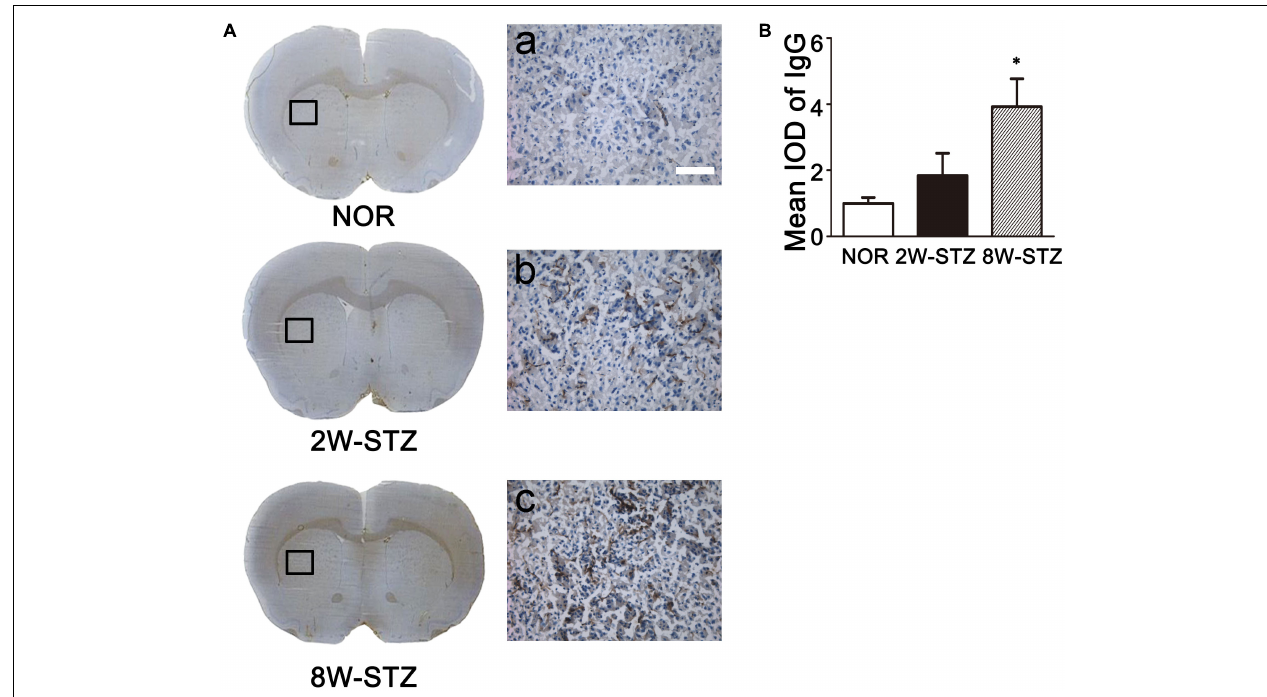
FIGURE 5 | Leakage of IgG in diabetic and normal rats. (A) Photomicrographs showed IgG staining in the diabetic and normal rats. Brown signal was the IgG positive protein leaked from the vessel. Boxes in images of NOR, 2W-STZ, and 8W-STZ are magnified to a. b and c, respectively, bar = 100 µ m. (B) Bar graph showed the quantification of IgG protein in the different groups. Data are mean ± SD, n = 6–8 per group. ∗ p < 0.05, 8W-STZ vs. NOR rats. NOR, normal rats; 2W-STZ, 2-week STZ; 8W-STZ = 8-week STZ; IOD, integrated optical